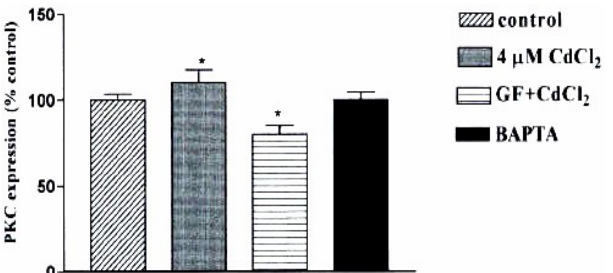
Figure 5: The antagonistic actions of GF109203X (GF) and BAPTA on CdCl induced stimulation of PKC-a/ß on expression 2 II 2 expression in SHR VSMCs. Cells were stimulated with 4 µM of CdCl for 5 min following treatment for 1 hr with each for the 2 2 antagonist. PKC-a/ß expression was determined by measuring specific blot. Densitometric analysis of western blots was done to quantify the magnitude of change in phosphorylation of MAPKs induced by CdCl . Bar graph represents intensities of MAPK 2 bands. The data are the mean± SEM of 3 to 4 different experiments. *p<0.05 compared to time-matched